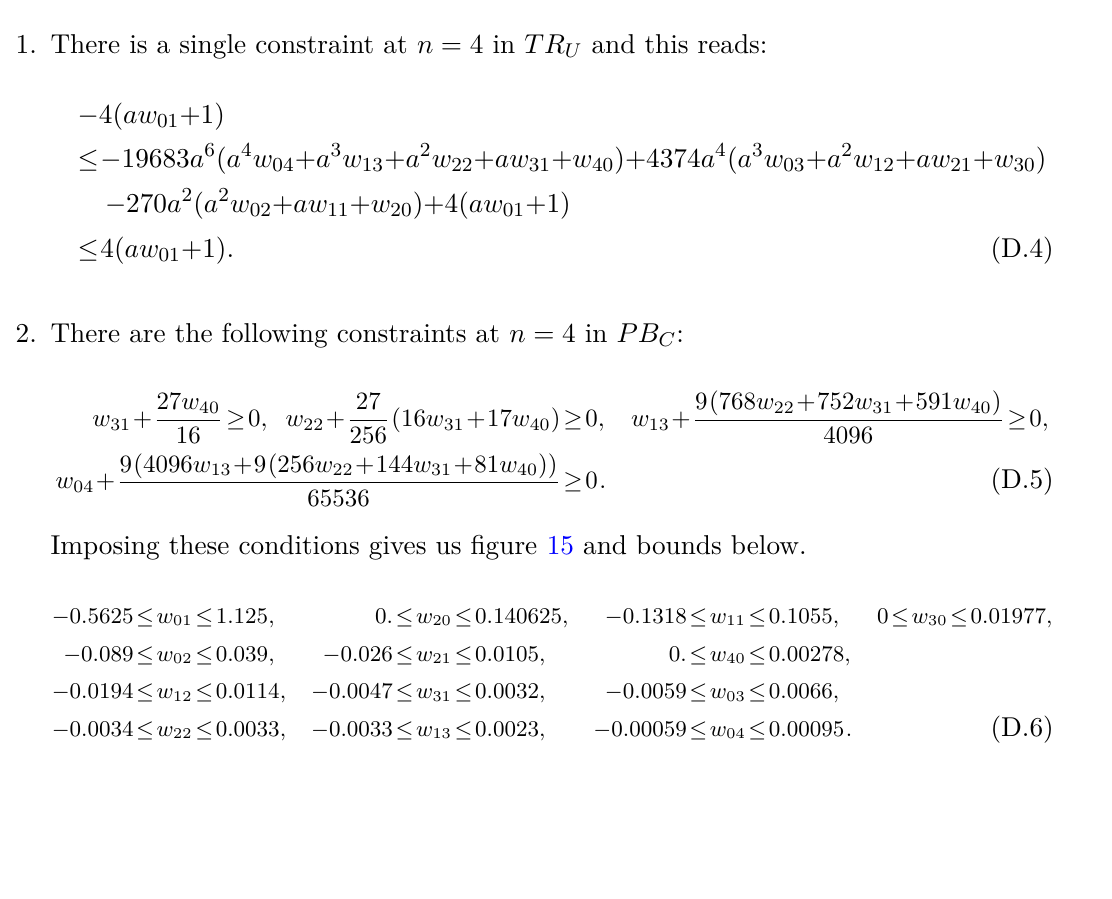
JHEP12(2021)203